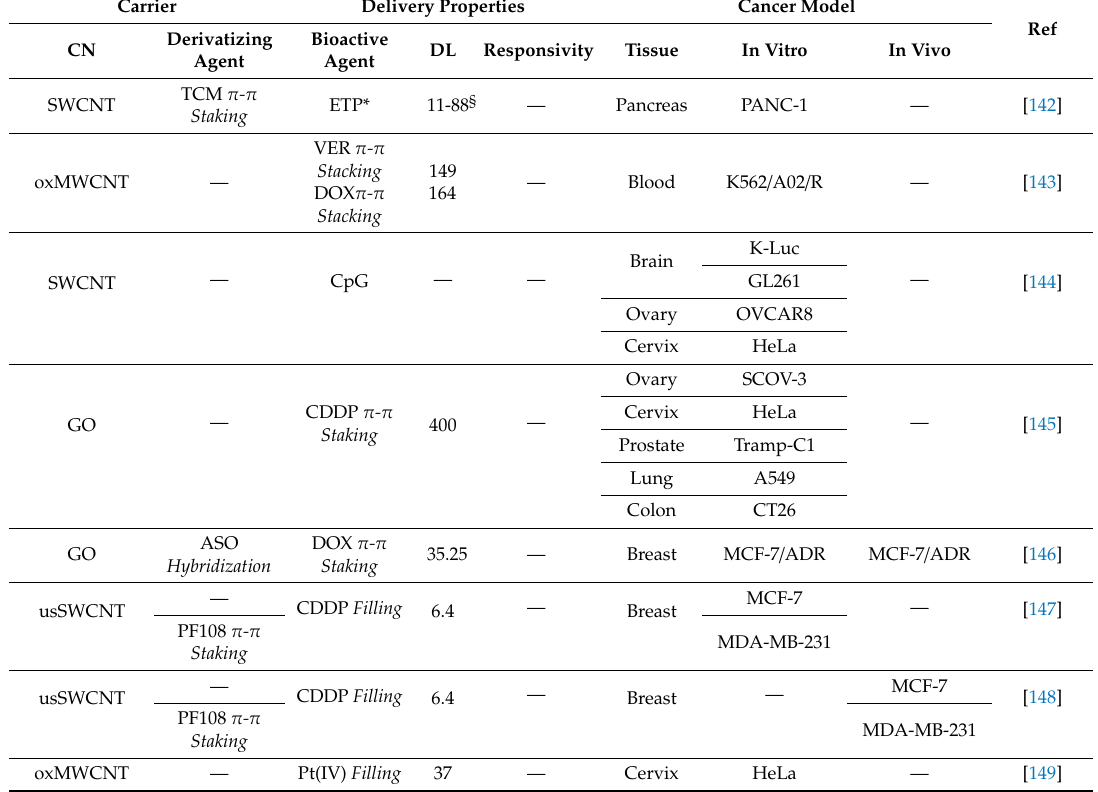
Table 3. MDR reversal by enhanced uptake of pristine and non-covalently functionalized